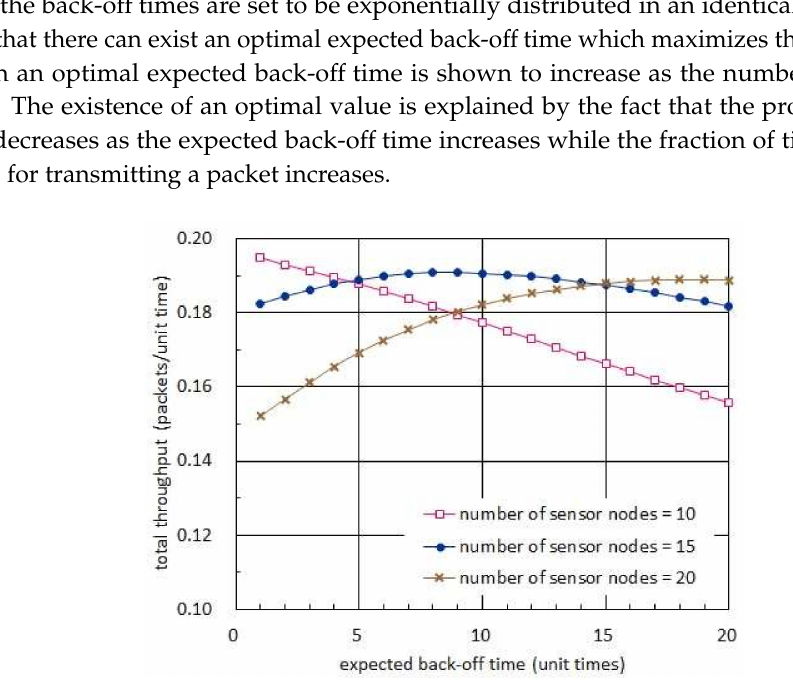
Figure 6. Total throughput with respect to expected back-o ff